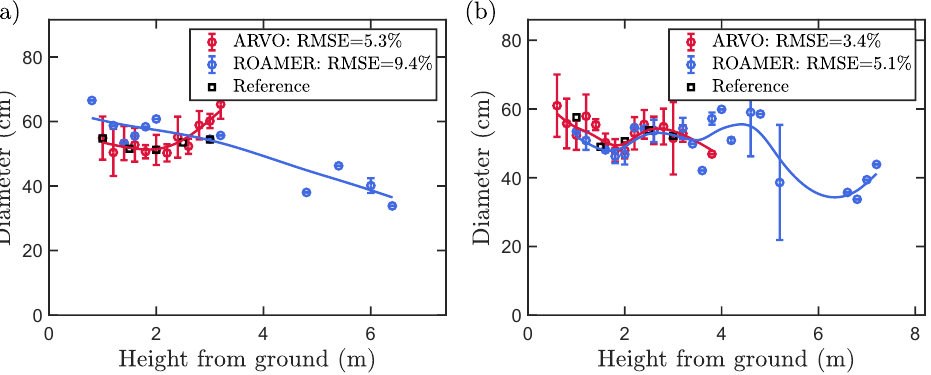
Figure 10. ( a ) A stem curve estimated for an example tree using the ARVO (red dots) and ROAMER systems (blue dots) together with the reference values of the stem diameter based on manual measure- ments (black squares). The solid lines show the smoothing spline fits the individual stem diameter measurements. The error bars correspond to the standard deviation of the diameters of the detected arcs in each height interval. The relative RMSE values for the stem curve estimate are 3.4% and 5.1% for the ARVO and ROAMER systems, respectively. ( b ) The same as ( a ) but for another tree. The RMSE values for the stem curve estimates are 5.3% and 9.4% for the ARVO and ROAMER systems,